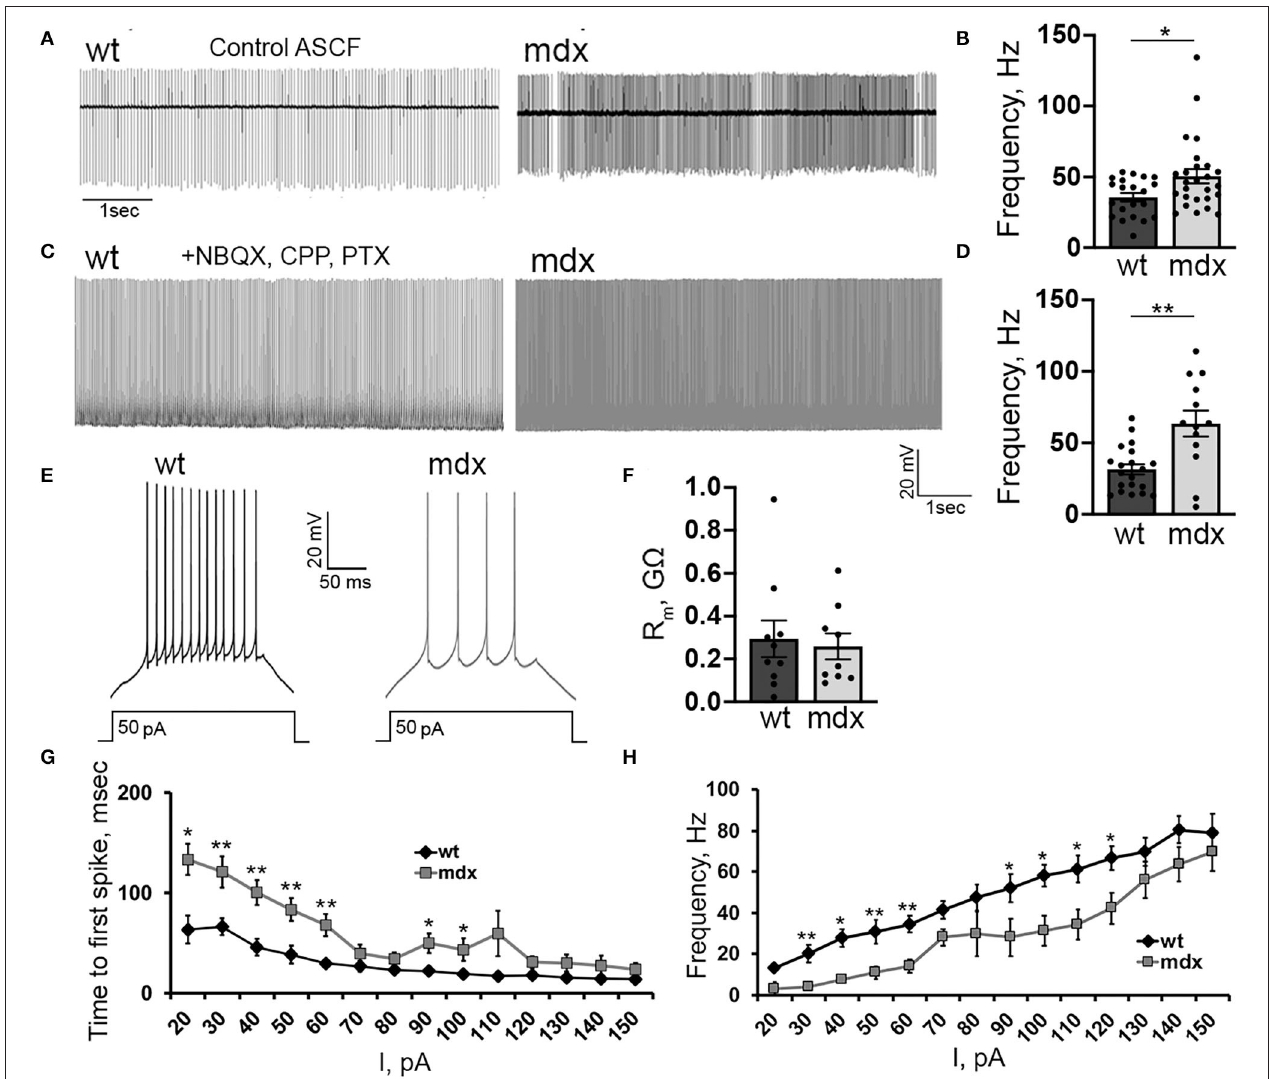
FIGURE 6 | Loss of dystrophin alters the intrinsic excitability of CbN glutamatergic projection neurons. Representative traces (A) and mean firing rate (B) from cell attached recordings of spontaneous firing of wild-type ( n = 11 cells from 3 animals) and mdx ( n = 19 cells from 5 animals) YFP + CbN neurons. Scale bar: 1s. Representative traces (C) and mean firing rate (D) from whole-cell recordings of spontaneous action potentials recorded in the presence of NBQX, CPP, and PTX from YFP + CbN neurons in wild-type ( n = 19 cells from 5 animals) and mdx ( n = 13 cells from 6 animals) mice. Scale bar: 20mV, 1s. (E) Representative traces of AP trains in current-clamped wild-type and mdx YFP + CbN neurons evoked by 200ms and 50pA current injections. Scale bar: 20mV, 50ms. (F–H) Summary graphs of mean membrane resistance (F) , mean time to first action potential (G) , and mean firing frequency during depolarizing current injections (H) in wild-type (dark gray, n = 9 cells from 3 animals) and mdx (light gray, n = 8 cells from 3 animals) YFP + CbN neurons. Error bars indicate SEM. * p ≤ 0.05, ** p ≤ 0.01.